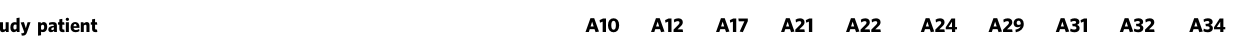
Table 1 Summary of patients and samples included in the study. Study patient Years between diagnosis and death from metastatic prostate